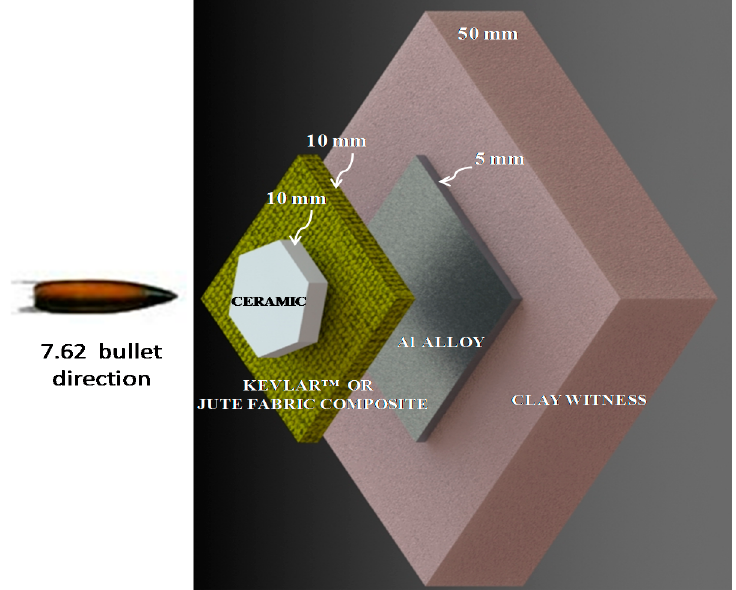
Figure 2. Schematic representation of the investigated multilayered armor placed ahead of a clay witness block.